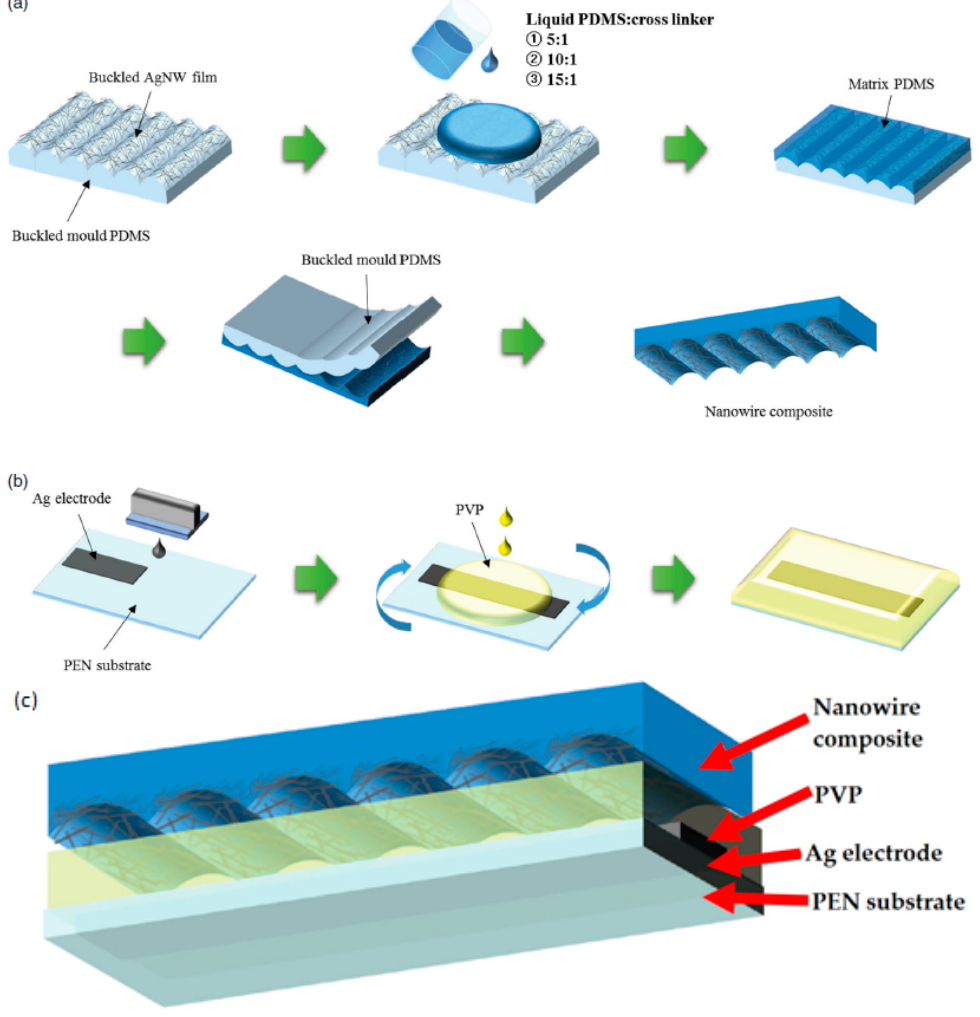
Figure 5. Fabrication process for the capacitive flexible pressure sensor with a nanowire composite and a bottom plane (redrawn from [62]). ( a ) Fabrication process for nanowire composites with different mixing ratios of the PDMS matrix; ( b ) Fabrication process for the bottom plane: the inkjet printing of the Ag electrode onto the PEN substrate and the spin coating of the PVP dielectric layer; ( c ) Layout of the final product.